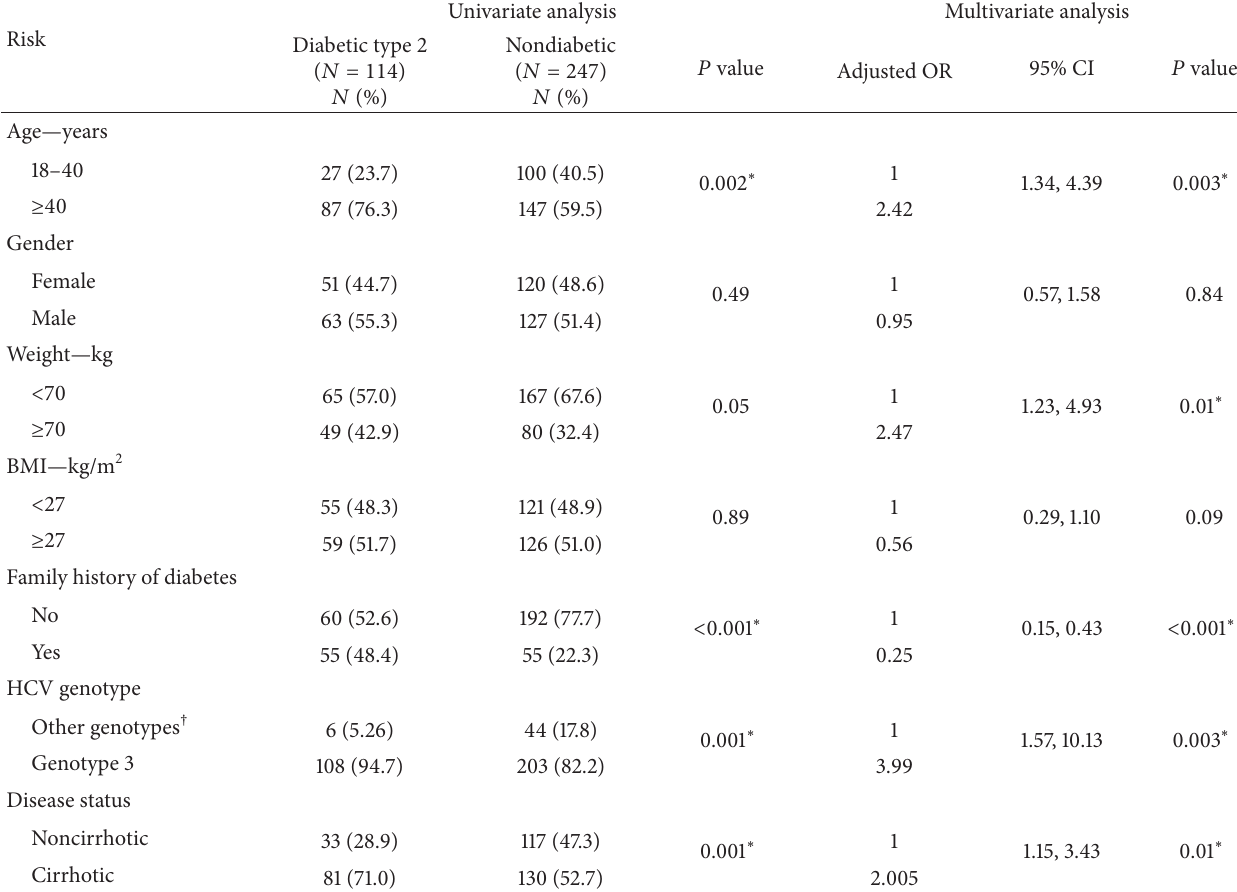
Table 3: Risk factor distribution between diabetic and non diabetic HCV seropositive